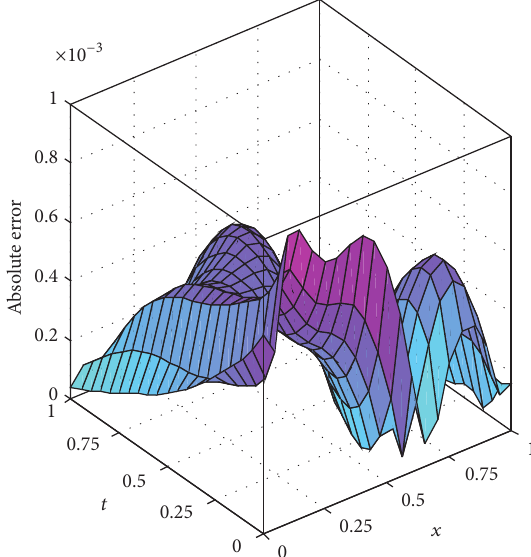
Figure 12: The absolute error for Example 3 with 𝑚 = 𝑛 = 10